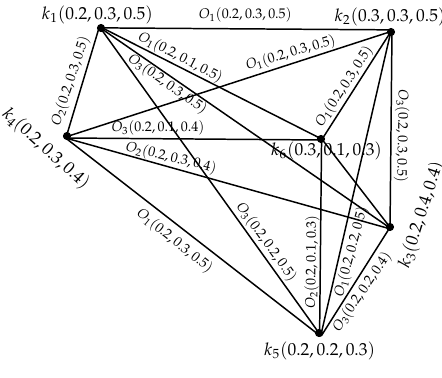
Figure 6. A complete